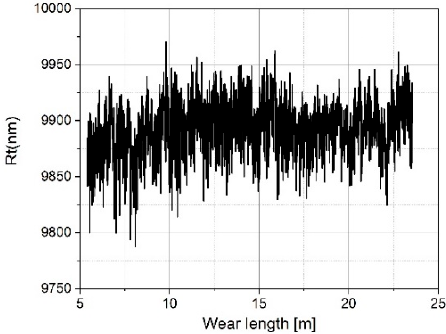
Figure 27. Measured Rt values on the roughness standard RN 6678 versus measurement length.